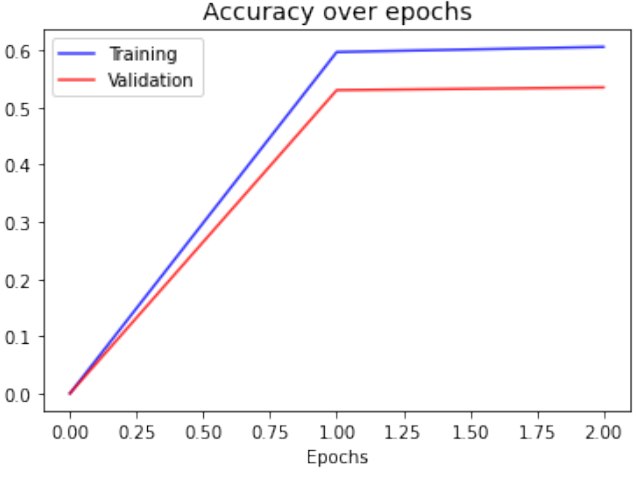
Figure 6. Validation curves for the final